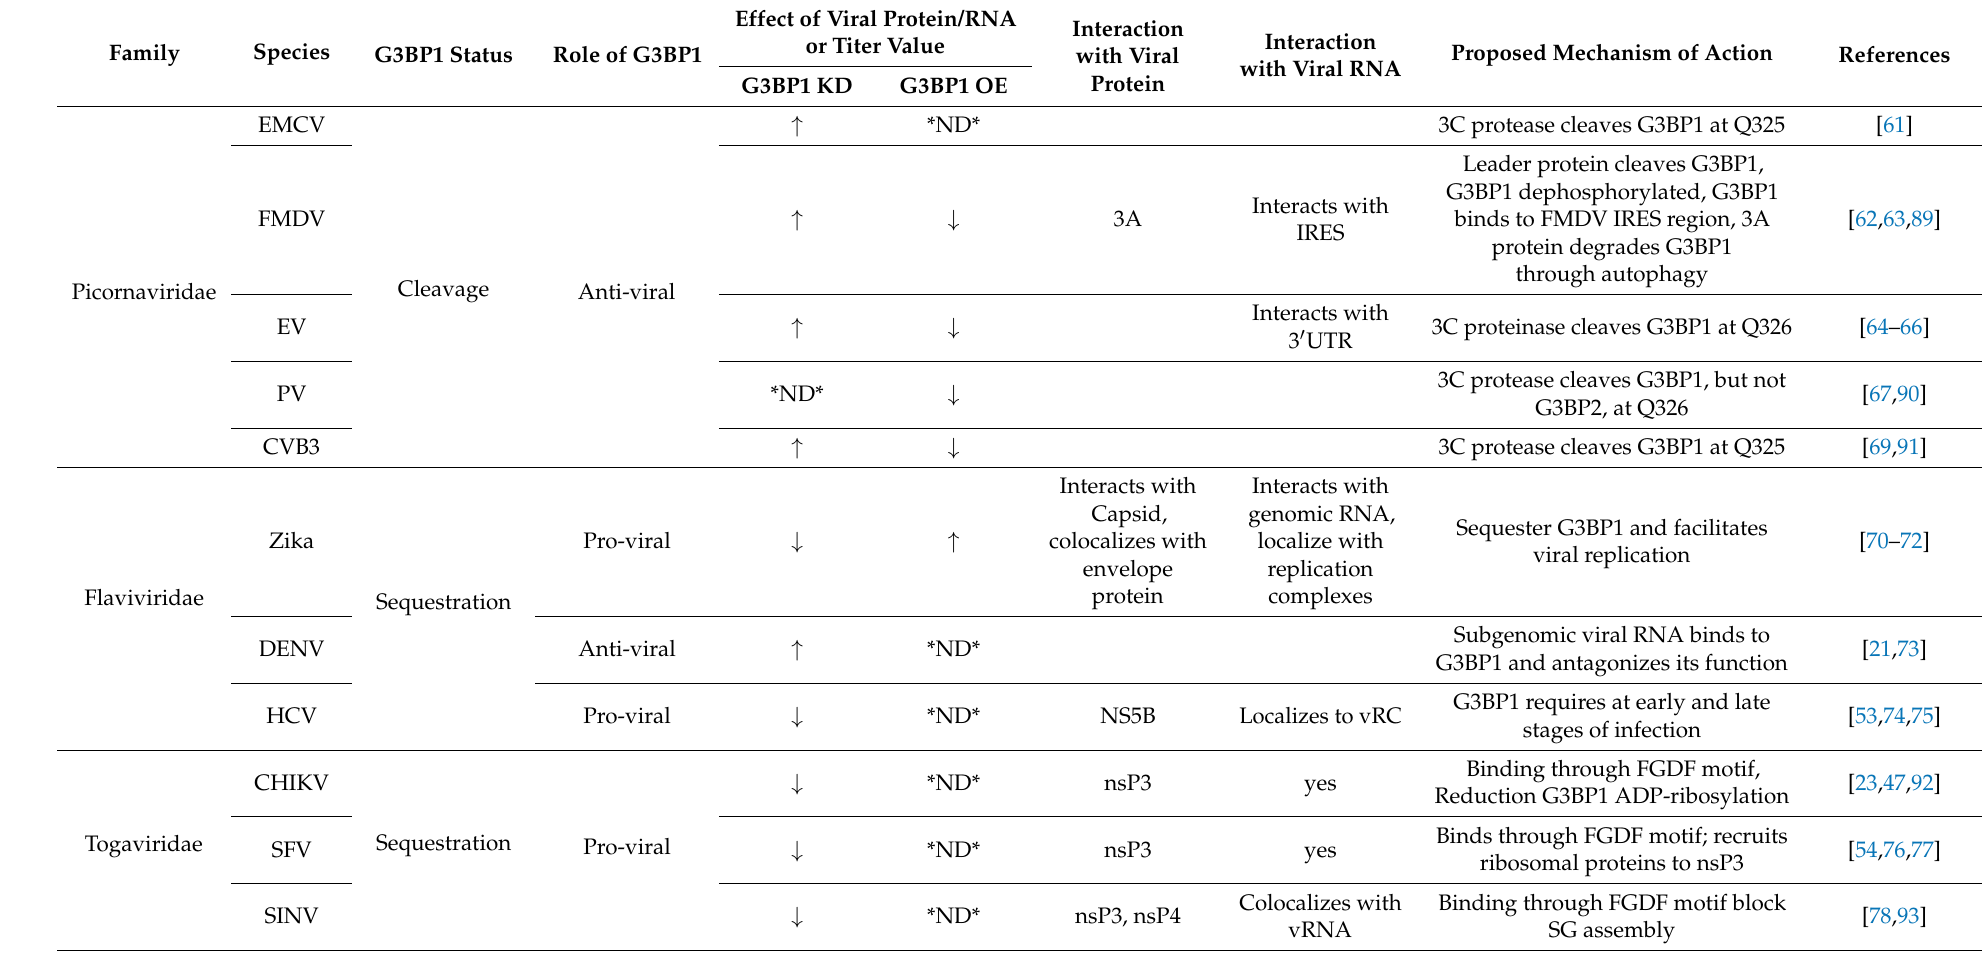
Table 2. Role of G3BP1 and proposed mechanism of viral